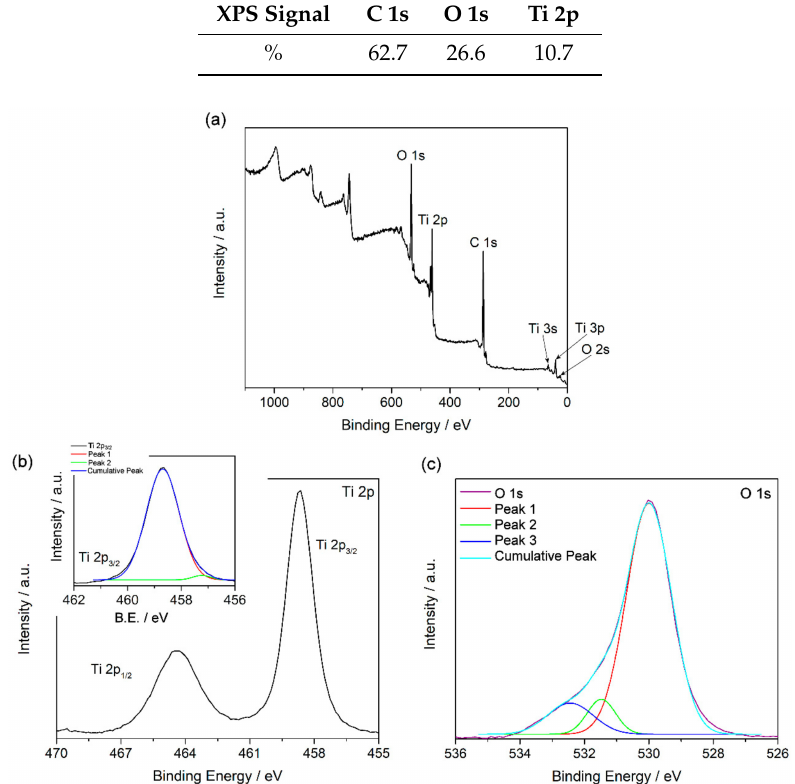
Figure 6. General X-ray photoelectron spectroscopy (XPS) spectrum for TiO 2 nanoparticles synthesized ( a ), signals for Ti 2p ( b ), and O 1s ( c ) obtained from XPS